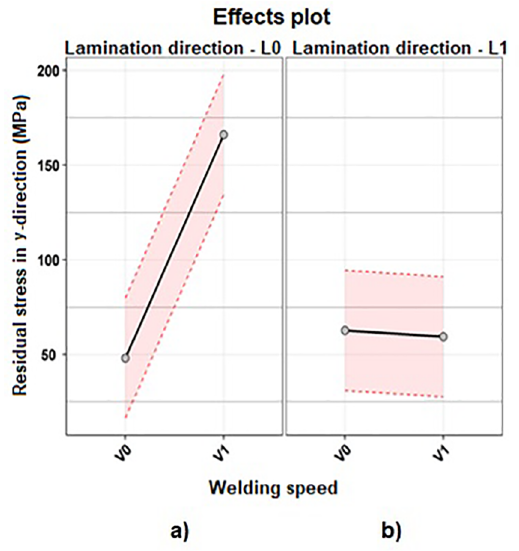
Figure 5. Graph of effects of welding speed and lamination direction a)L0 and b)L1 in the residual stress in Y